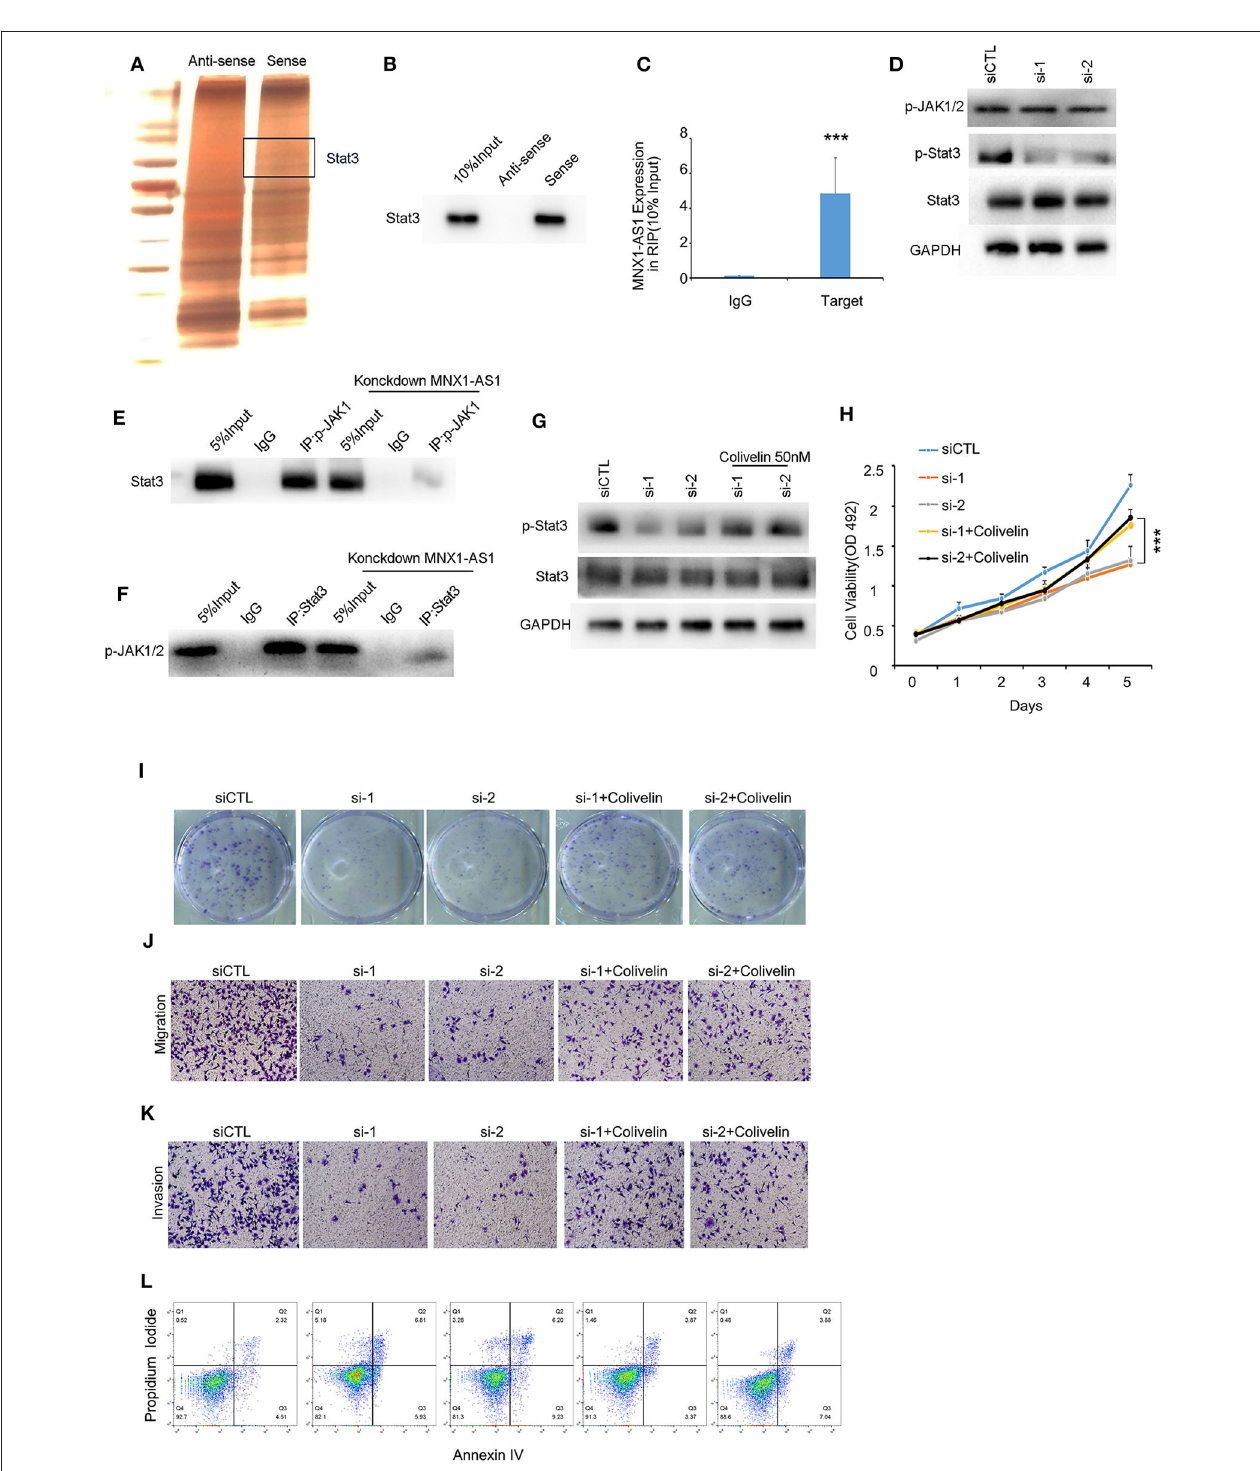
FIGURE 3 | MNX1-AS1 interacts State3 and promotes phosphorylation of Stat3 by enhance the interaction between p-JAK and Stat3. (A) Silver staining of proteins bound to MNX1-AS1. The RNA pull-down assay was performed with MDA-MB-231 cell lysates. A specific band was identified as Stat3 by mass spectrometry. (B) Stat3 interacted with MNX1-AS1 was confirmed by RNA pull-down assay and Western blot. (C) MNX1-AS1 interacted with Stat3 was confirmed by RNA immunoprecipitation (RIP). Bar graphs represent the mean ± SD of experimental triplicates. (D) Silencing MNX1-AS1 reduced phosphorylation of Stat3 but had no effect on phosphorylation of JAK1/2 in MDA-MB-231 cells, as indicated by Western blot. (E,F) Silencing MNX1-AS1 reduced the interaction between Stat3 and p-JAK1/2. (G) Phosphorylation of Stat3 reduced by silencing MNX1-AS1 was rescued by Stat agonist colivelin 50nM. (H) Viability of MDA-MB-231 cell o reduced